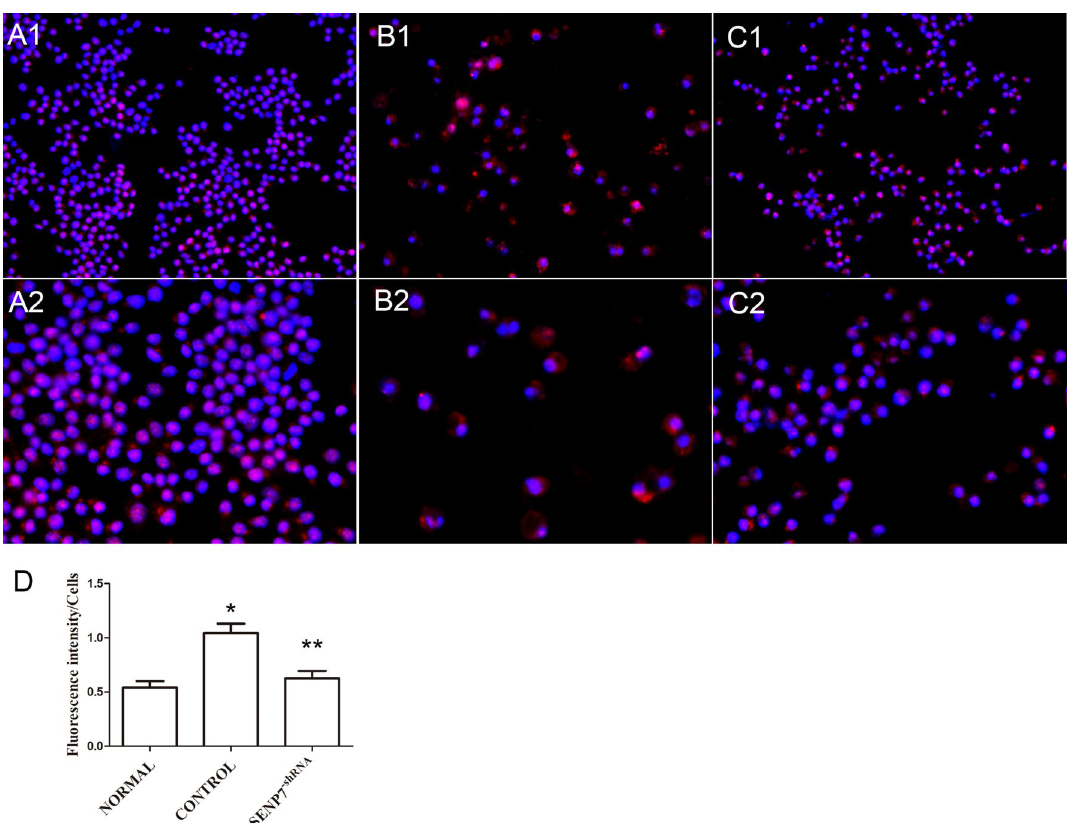
Figure 2. The GSDMD expression detected by immunofluorescence assay. The protein expressions of GSDMD were analyzed by immunofluorescence assay. GSDMD was probed by GSDMD antibody, The nucleus was stained by DAPI. ( A1 , A2 ) Raw 264.7 cells without any treatment, ( A1 ) (× 200), ( A2 ) (× 400); ( B1 , B2 ) Raw264.7 cells treated with LPS + ATP; ( C1 , C2 ) SENP7 stable knockdown Raw 264.7 cells treated with LPS + ATP. ( A1 , B1 , C1 ) (× 200), ( A2 , B2 , C2 ) (× 400). ( D ) The relative protein expression levels of GSDMD from three independent pictures were represented as the density of GSDMD fluorescence intensity normalized to numbers of cells. Compared with the NORMAL group, * p < 0.05, compared with the CONTROL group, ** p <